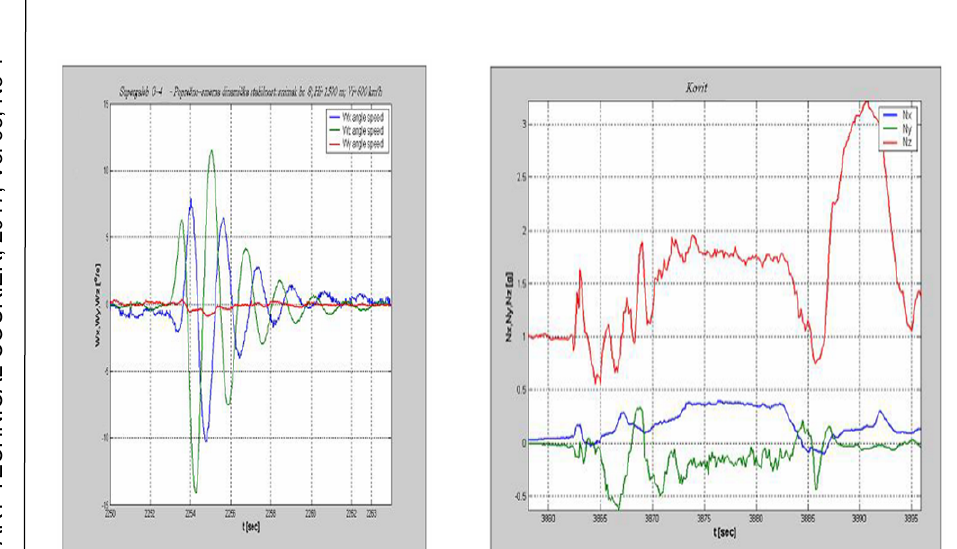
Figure 15 – Graphic display of testing cross directional stability and dynamic spin on the G-4